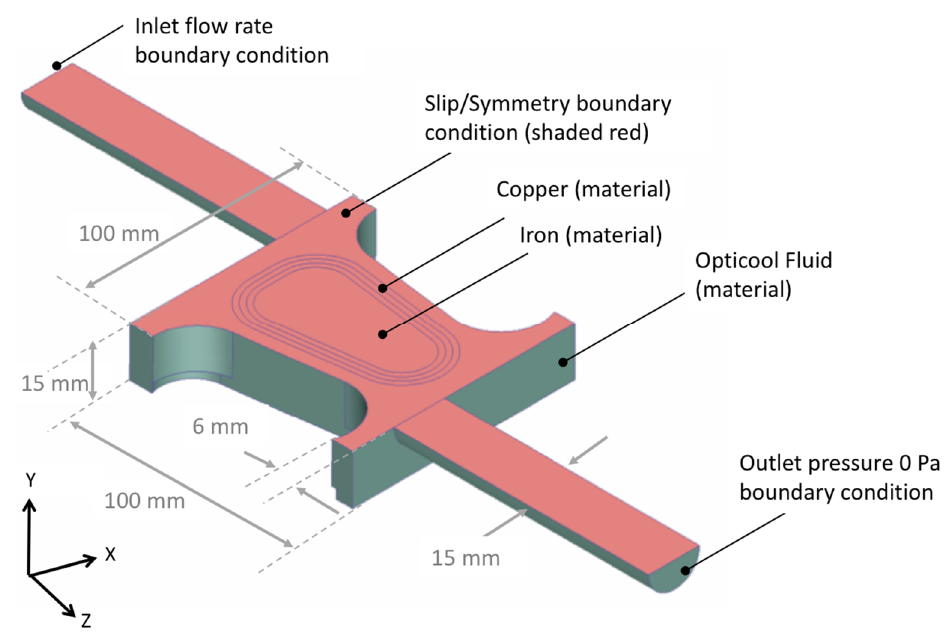
Figure 5. 3D CAD geometry and Boundary conditions for the single channel.